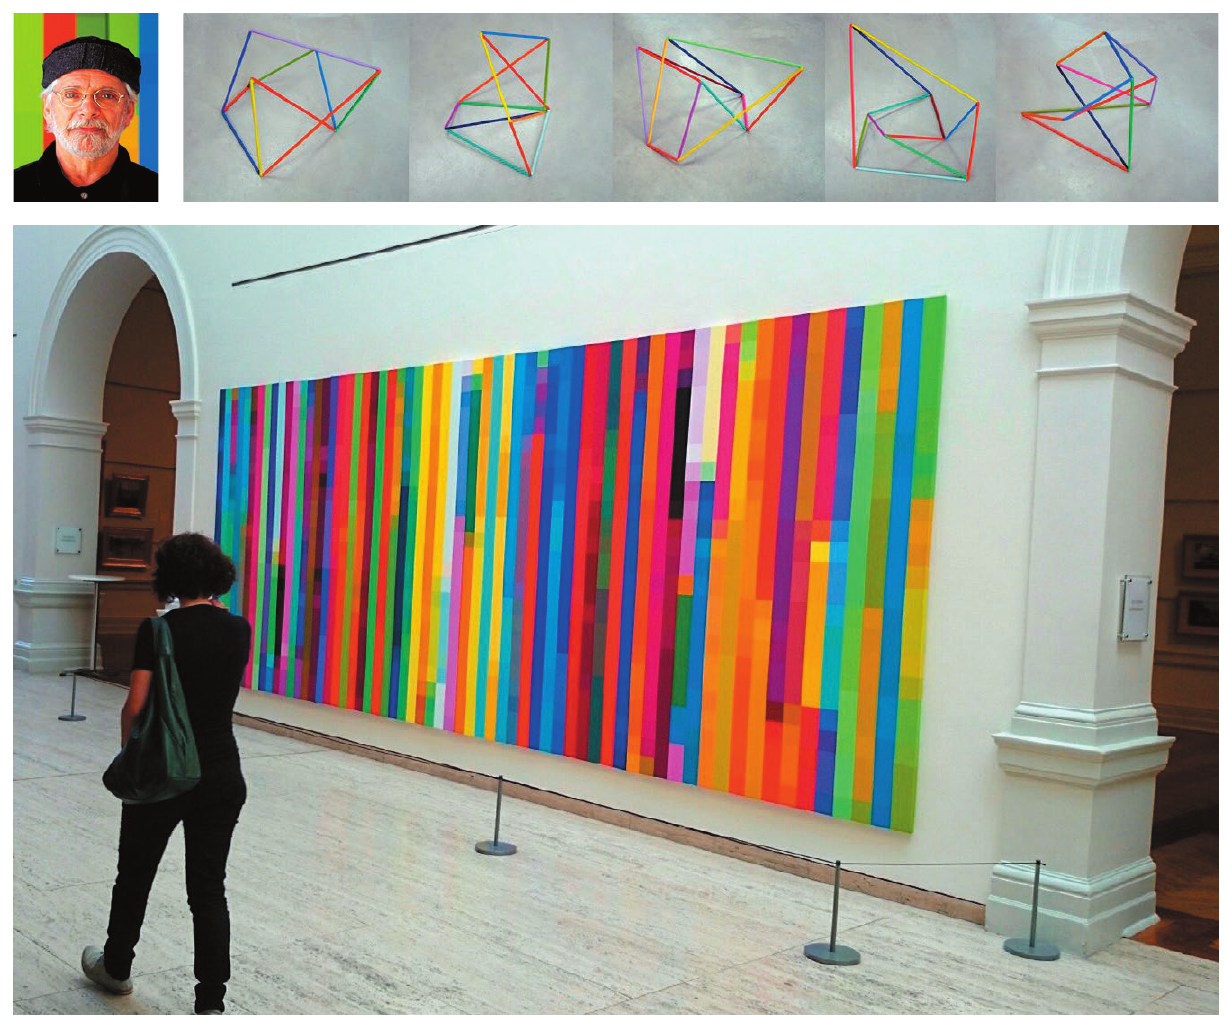
Figure 2. (L to R:) Models for Florentia (2006). Robert Owen. Cadence no. 1 (a short span of time) ,